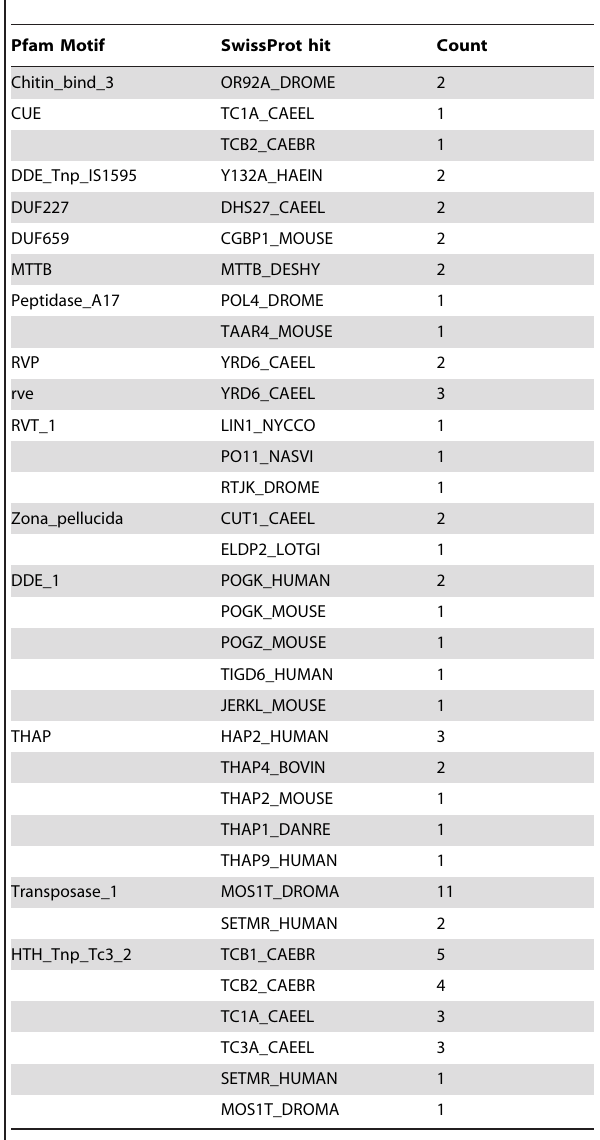
Table 1. The most frequent Pfam motifs identified in the novel